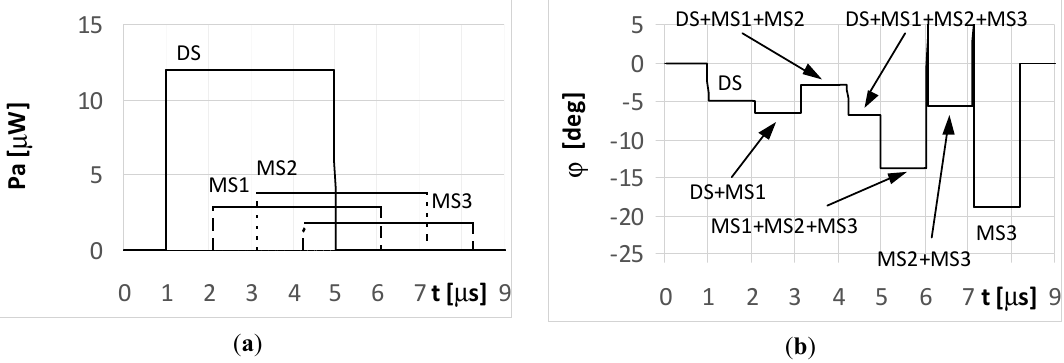
Figure 6. Envelopes of the direct signal (DS) and multipath signals (MS1, MS2, MS3) reflected from the ground, overlapping in time, and reaching UAV1 (shown in Figure 1) ( a ), and temporary angle of arrival ϕ estimated from the received resultant signal ( b ), (radar transmits simple long pulsed signal with duration t i = 4 µ s , and initial phases Φ 0D = Φ 01 = Φ 02 = Φ 03 = 0 ◦ ; AOA was estimated using the monopulse phase method from the DF device installed on UAV1 ).